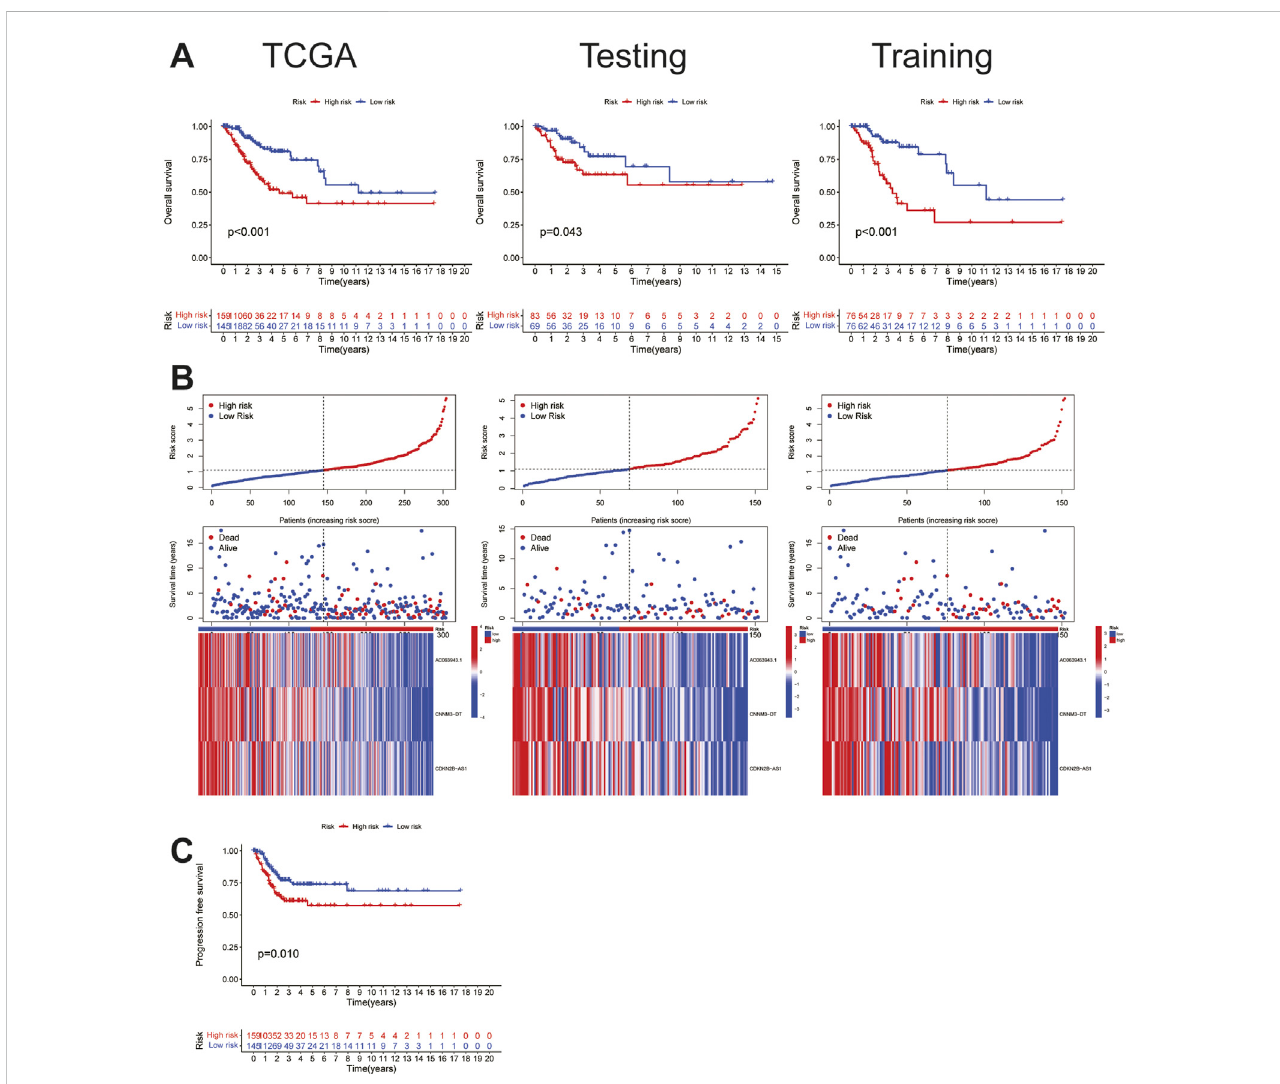
FIGURE 2 Characteristics of cuproptosis-related lncRNA signature. (A) The OS survival analysis of TCGA(risk) set, the training set, and the testing set. (B) Risk characteristics between high and low risk groups in TCGA(risk) set, the training set, and the testing set. (C) The PFS survival analysis in TCGA(risk) set.